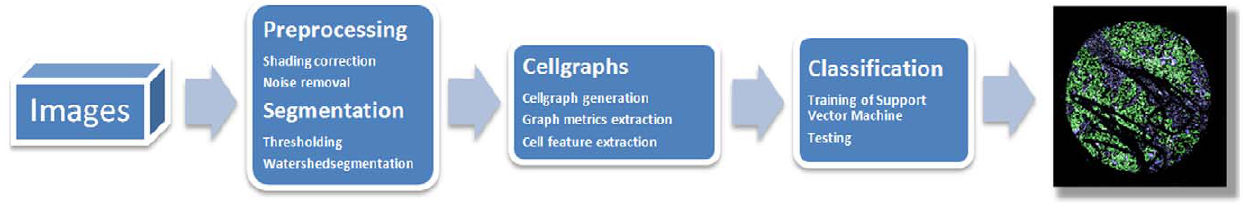
Figure 2. A Flowchart showing the single steps of our methodology. After obtaining the images, pre-processing steps enhance the image quality and watershed segmentation for the subsequent segmentation is applied. Accordingly the cell graphs are generated and features are computerized. The last step uses a SVM to classify the graphs as either tumor or stroma.